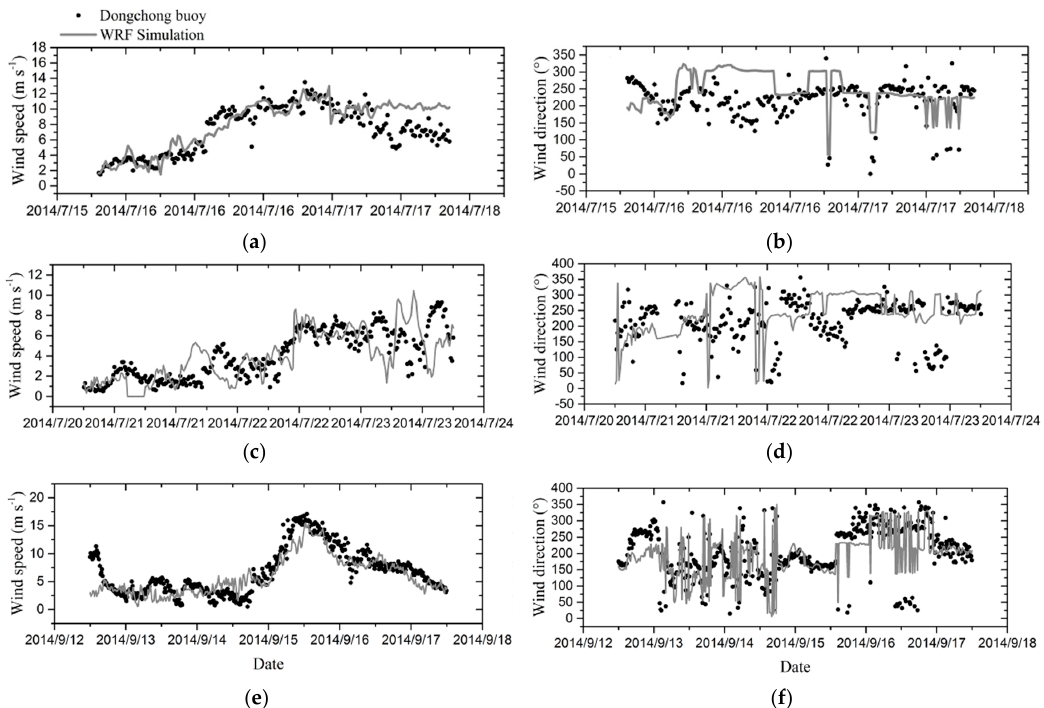
Figure 4. The comparisons between observed and simulated wind speed and direction at 3 m-elevation from 15 to 18 July, from 20 to 24 July and from 12 to 18 September in 2014: ( a ) the wind speed of Typhoon Rammasun; ( b ) the wind direction of Typhoon Rammasun; ( c ) the wind speed of Typhoon Matmo; ( d ) the wind direction of Typhoon Matmo; ( e ) the wind speed of Typhoon Kalmaegi; and ( f ) the wind direction of Typhoon Kalmaegi.